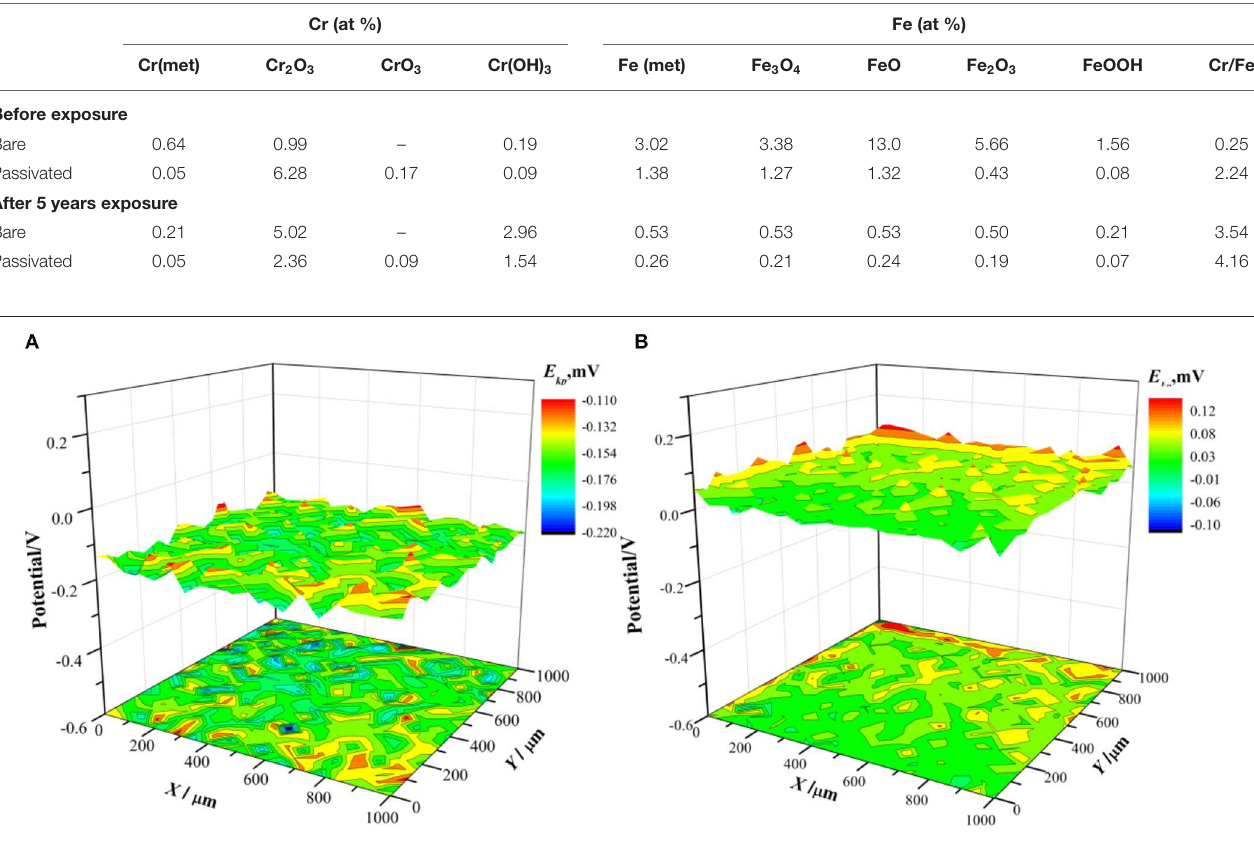
FIGURE 11 | Surface Kelvin potential distribution after 5 year exposure (A) bare sample; (B) pre-passivated sample.